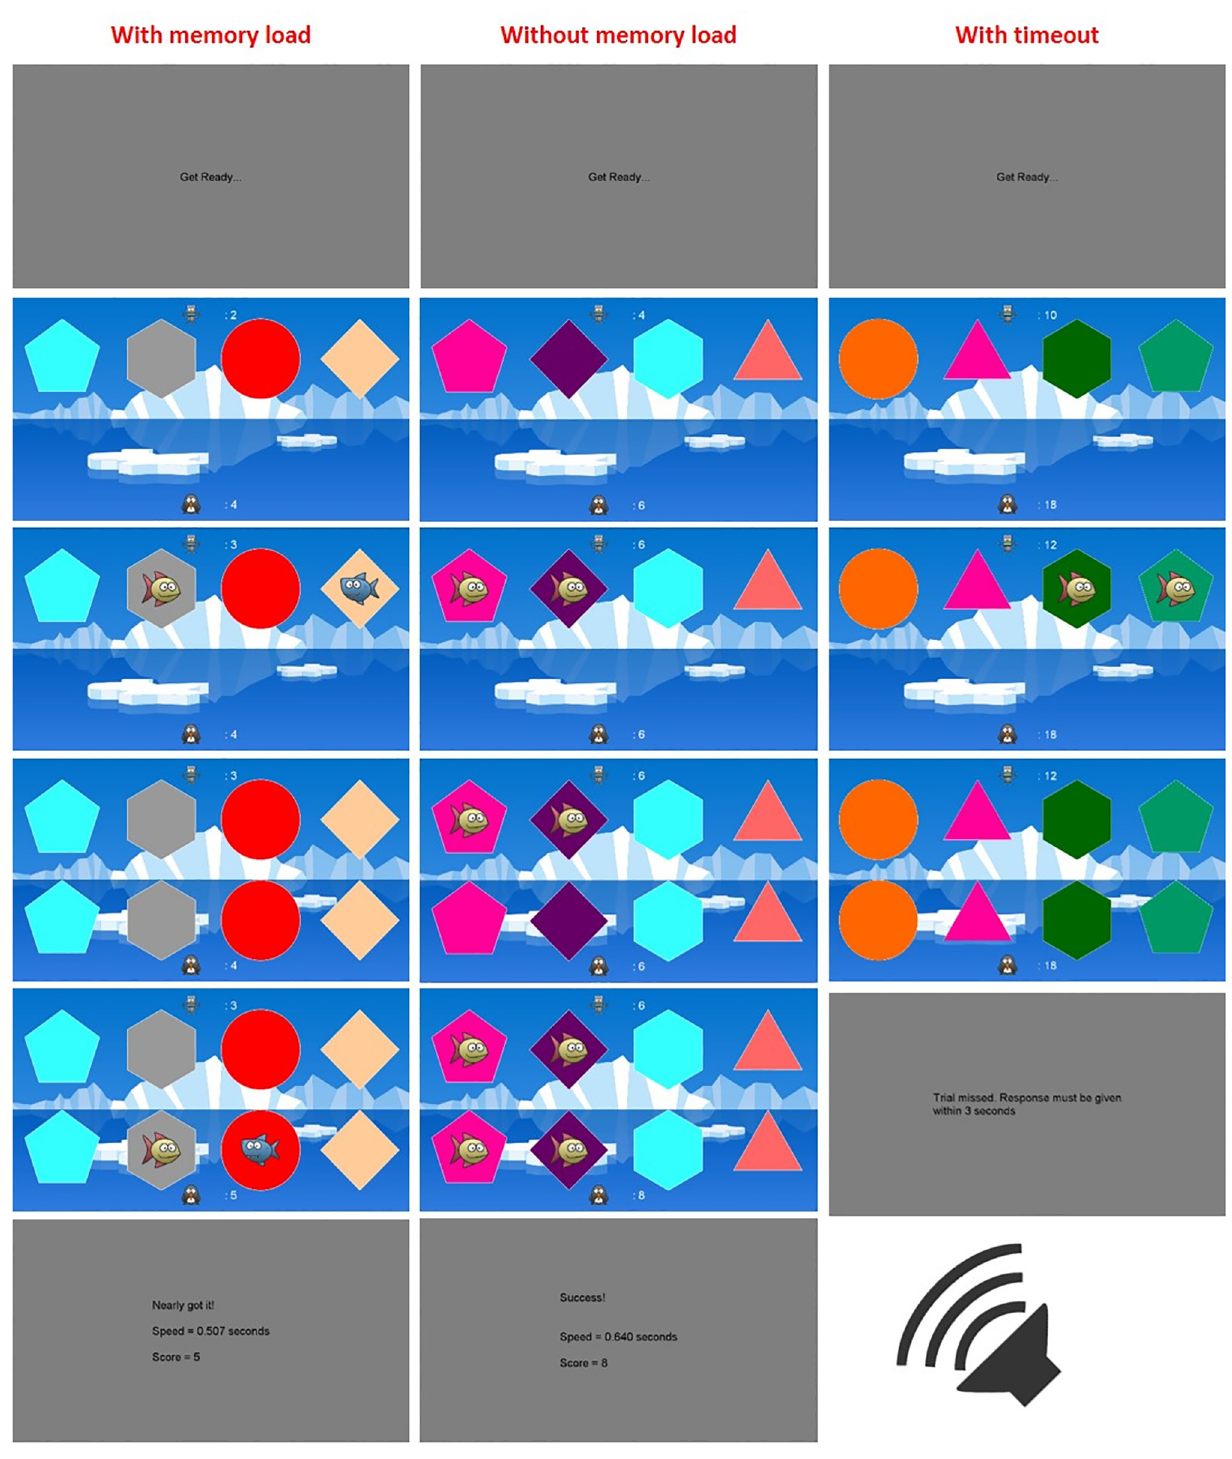
Fig 4. Example trials of the choice task. In all conditions the task was completed alongside the audio switching task. Left: an information trial with one succesful (fish) and one unsuccesful (shark) stimuli, with an additional memory load. The test trial shows the participant has used a correct strategy and repeated the successful information, and shifted away from the unsuccesful information, although due to chance they have selected one unrewarded stimulus. Middle: an information trial with two successful stimuli, with no memory load. The test trial shows two successful stimuli are selected. Right: a trial with a timeout for no